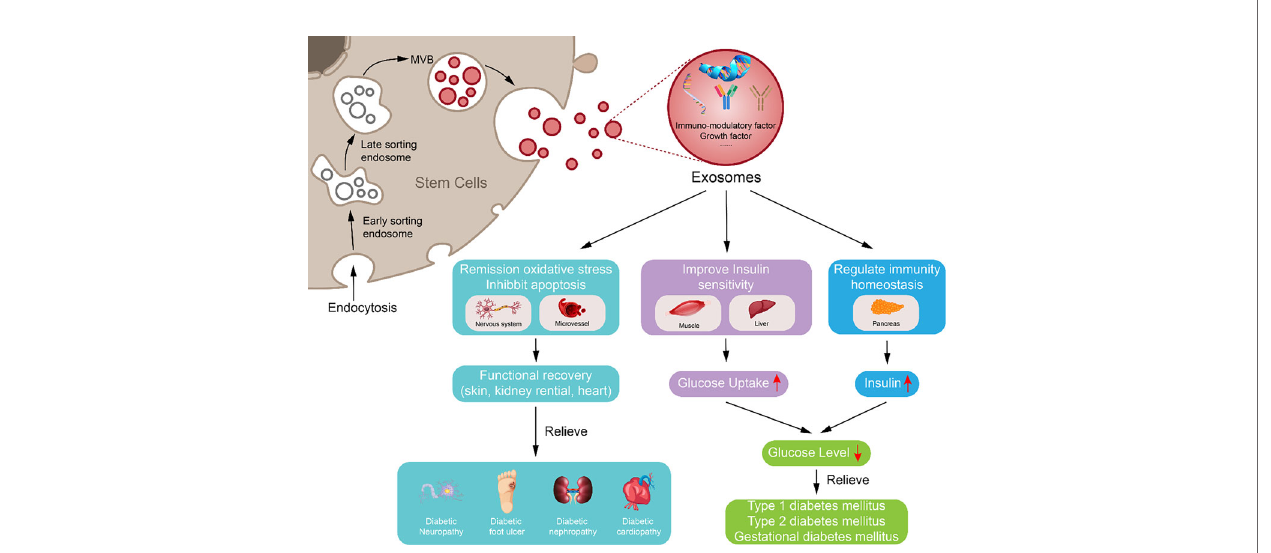
FIGURE 2 | Potential approach of exosomes derived from mesenchymal stem cell in diabetes mellitus and diabetic complication repair. Exosome derived from mesenchymal stem cell may downregulate blood glucose through reversing peripheral tissue (liver and muscle) insulin resistance and increasing b -cell survival during remission of diabetes mellitus; exosome derived from mesenchymal stem cell can inhibit apoptosis, oxidative stress, and immune reaction to reduce vascular or neuron injury and carry growth factors to increase damaged tissue or cell repair, which may participate in alleviating diabetic